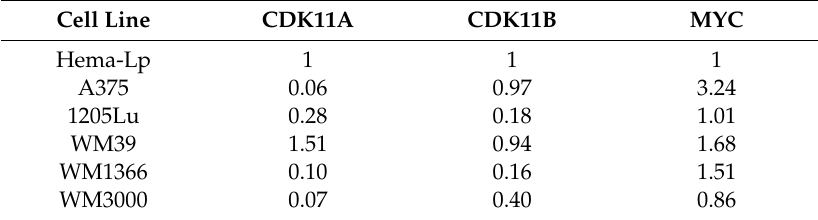
Table 2. mRNA expression levels in melanoma cell lines relative to non-transformed melanocytes.